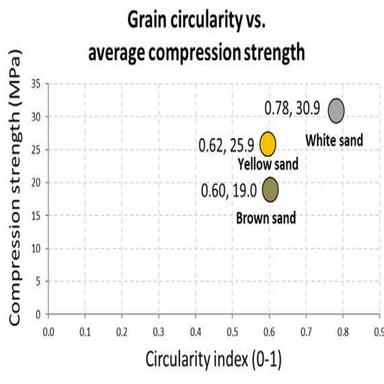
Circularity vs. average compressive strength.